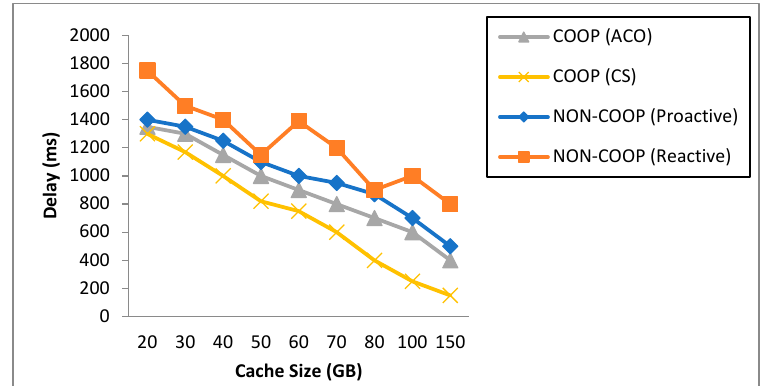
Figure 9. Delay with different cache sizes.